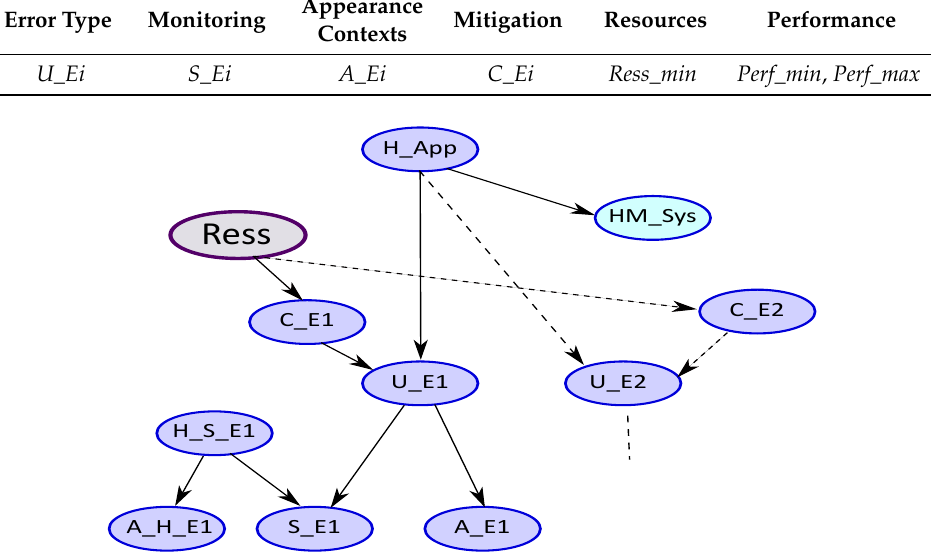
Figure 10. FMEA _ EMB pattern where the hardware resource is represented by the node Ress